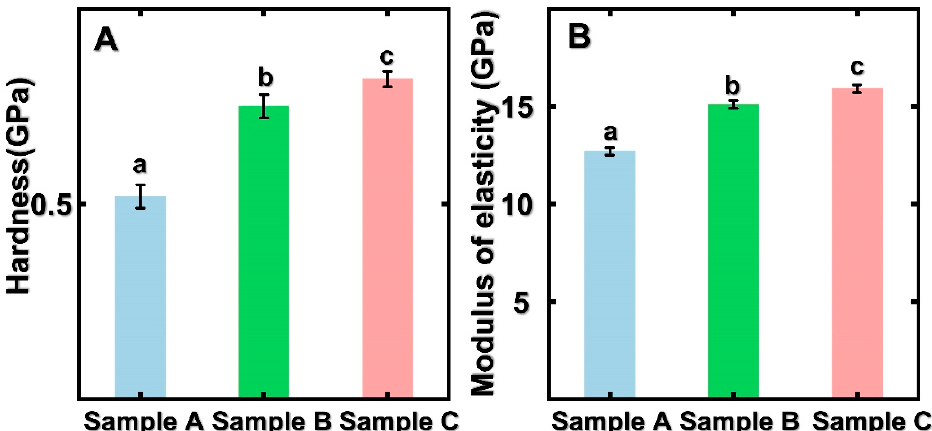
Figure 6. Micro-mechanics of control and treated bamboo samples: ( A ) hardness; ( B ) modulus of elasticity; significant differences between heat treatment groups ( p < 0.05) were presented by different small letters. The error bar in the picture represents the standard deviation.